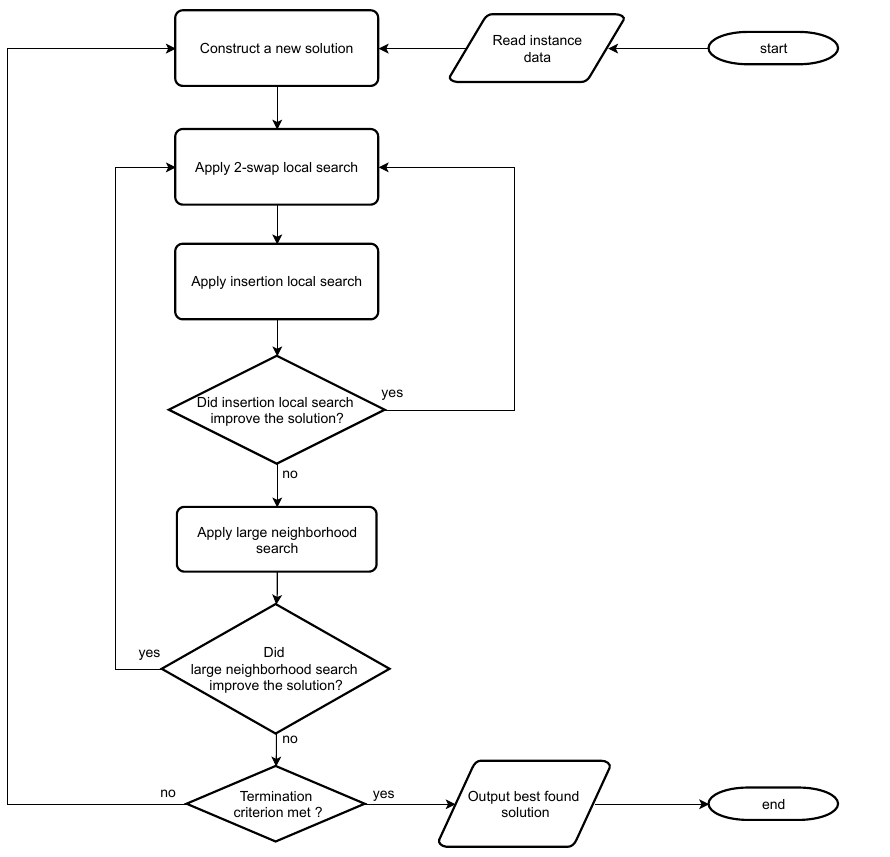
Figure 4. The flowchart of the the main steps of the RDIS